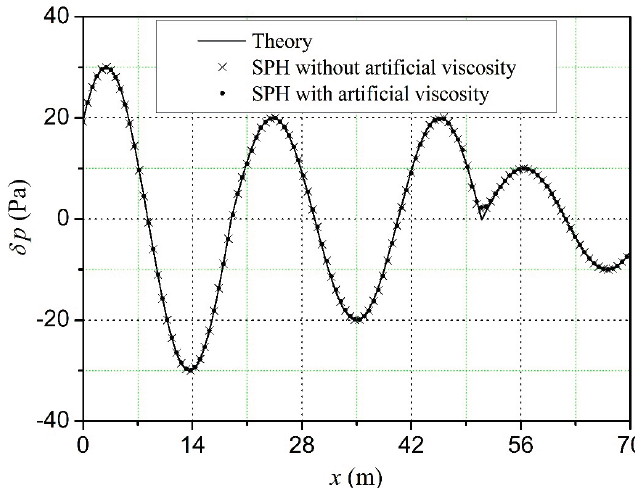
Figure 4. Sound interference pressure of acoustic waves at t = 0.15